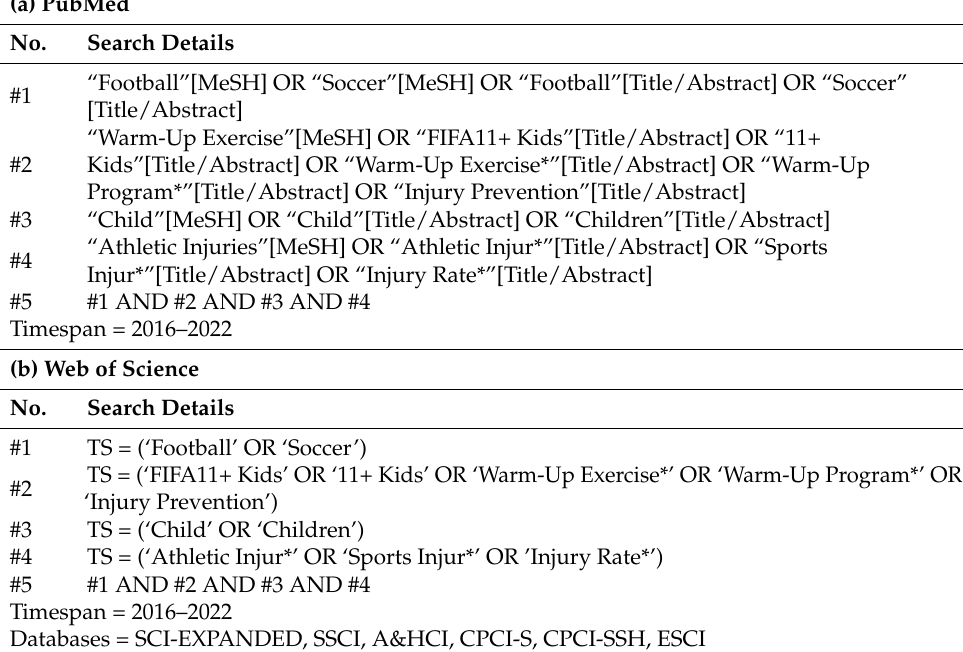
Table A1. Search strategies for all